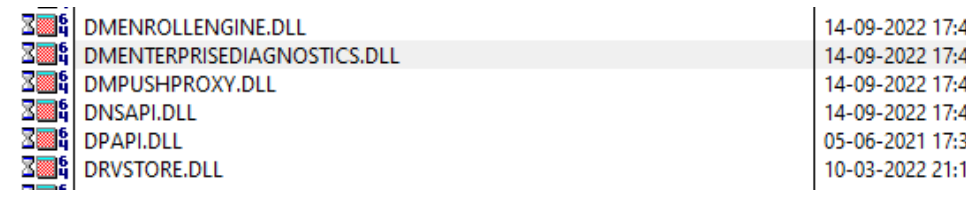
Figure 7. Malicious DLL used in malware